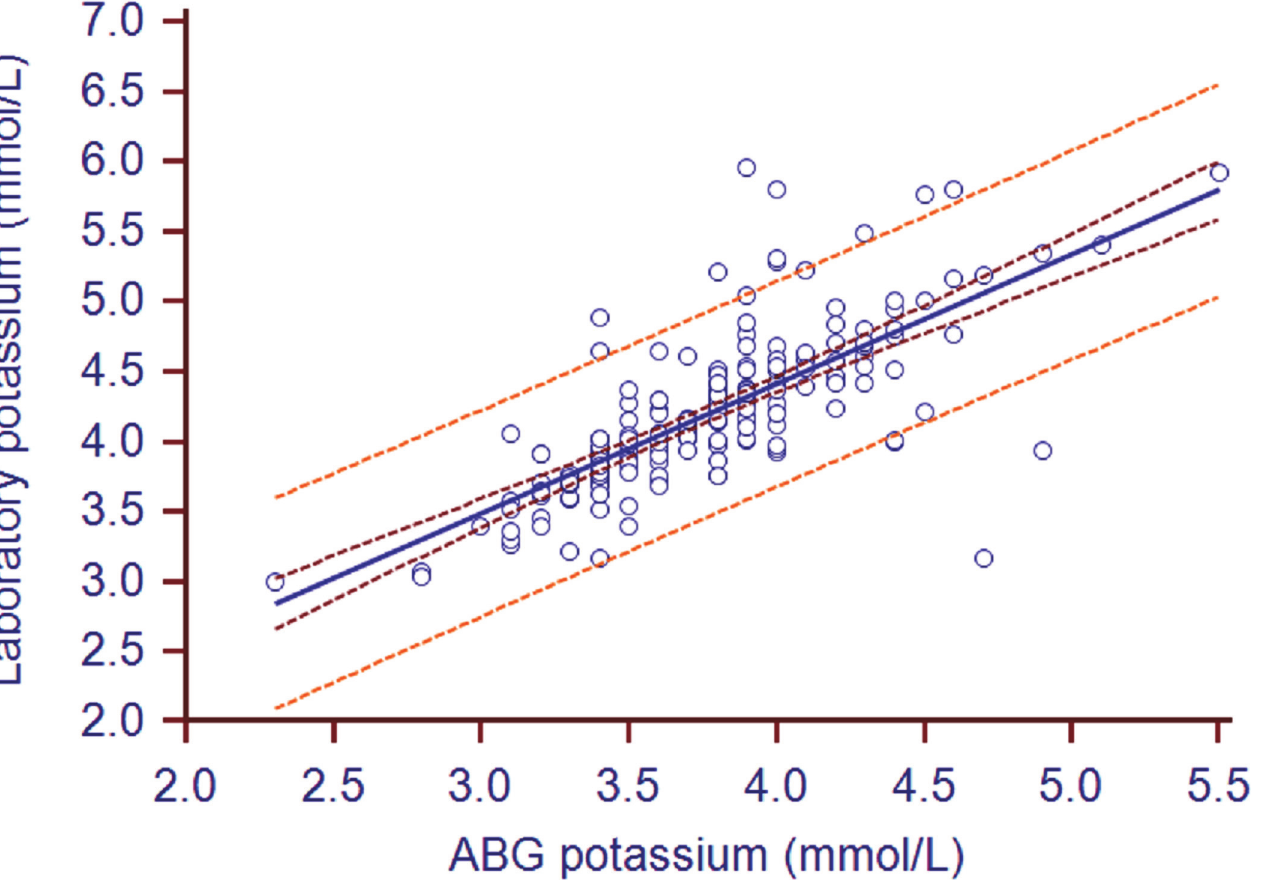
Fig 2. Potassium scatter plot with Deming fit. Concordance plot shows agreement between laboratory- and ABG-measured potassium (in mmol/L). The solid line indicates the correlation coefficient (r = 0.74). The brown line indicates the 95%CI of correlation coefficient (0.67 to 0.8). The orange line indicates the